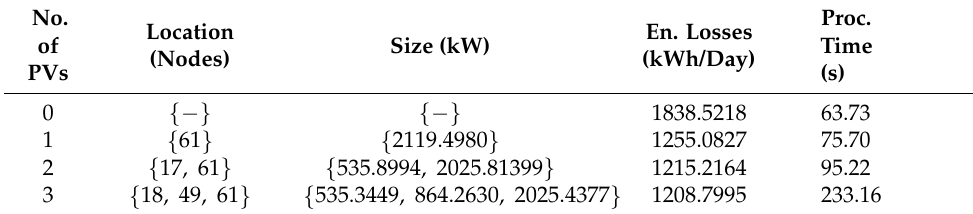
Table 4. Siting and dimensioning of PV sources in DC grids using the proposed MI-SOCP.